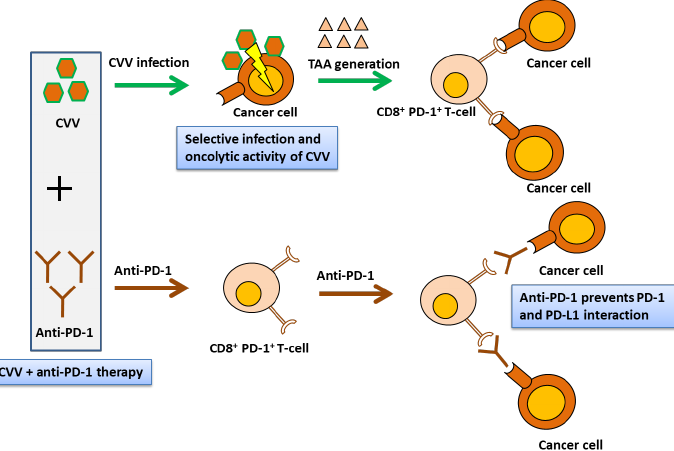
Figure 9. CVV and anti-PD-1-based combination therapy restores antitumor immunity in the TME. Simultaneous CVV and anti-PD-1 combination therapy induced CD8 + PD-1 + T-cell infiltration in